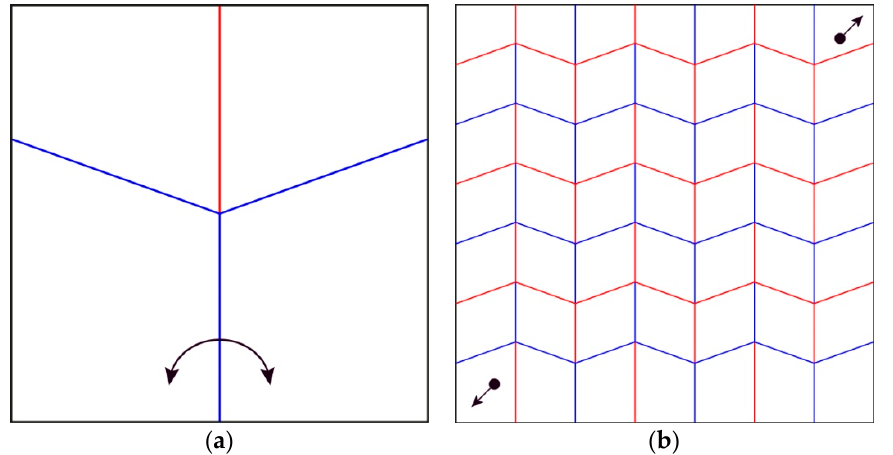
Figure 2. Miura-ori tessellation adapted from Miura [10]. ( a ) Shows one unit cell of the Miura-ori pattern; ( b ) presents how this cell can be duplicated. The arrows display actuation mechanisms to unfold the